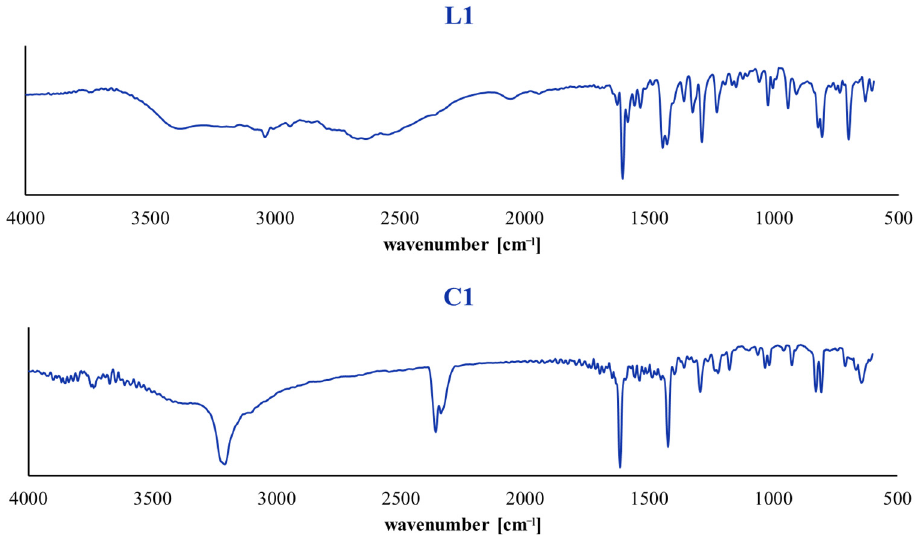
Figure 1. FTIR spectrum of free organic ligands L1 and complex C1 .